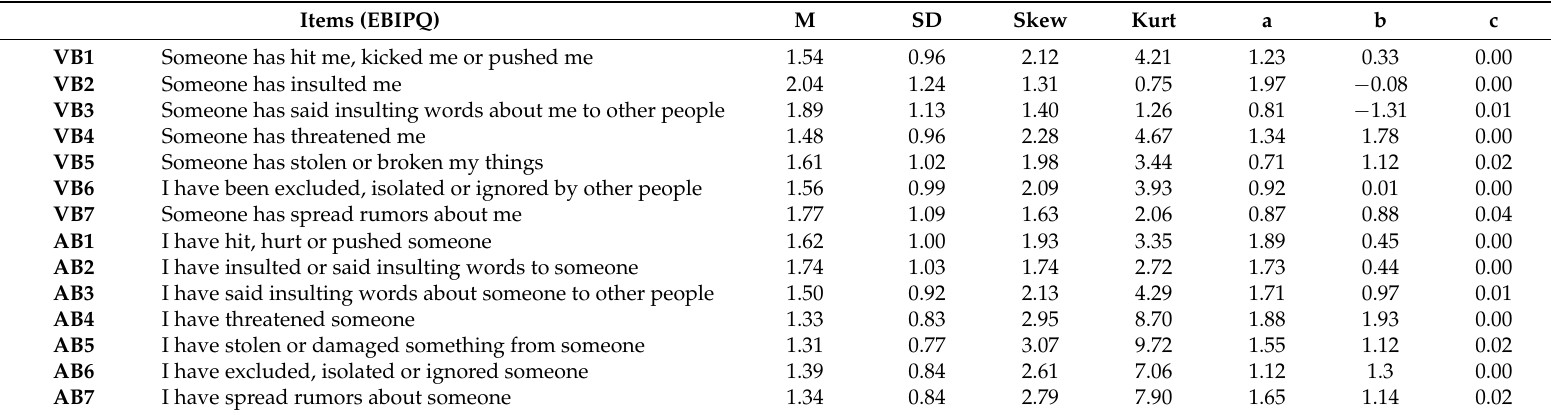
Table 1. Mean, standard deviation, skewness, kurtosis, and 4PL analysis (Item Response Theory, IRT).